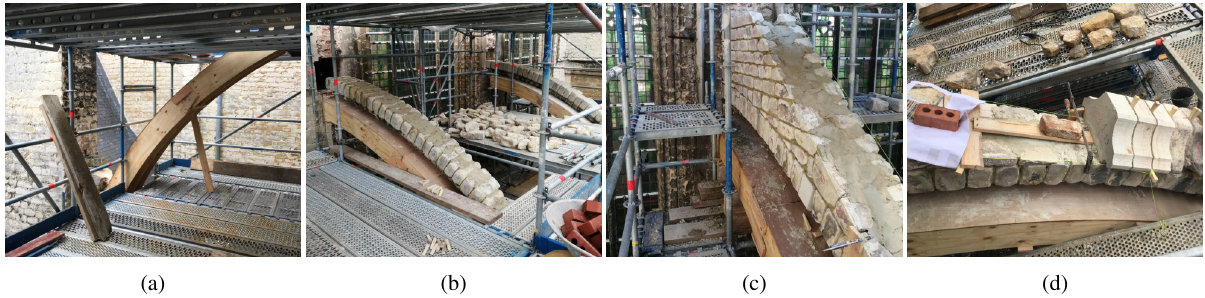
Figure 5: Extraction of some of the plan elements for the new design of one of the flying buttresses depicting the design workflow. (a) 3D spline creation (b) extrusion of profile along spline (c) 3D visualisation of the extruded top and bottom row of the arch (d) 2D plan with indications for each stone.